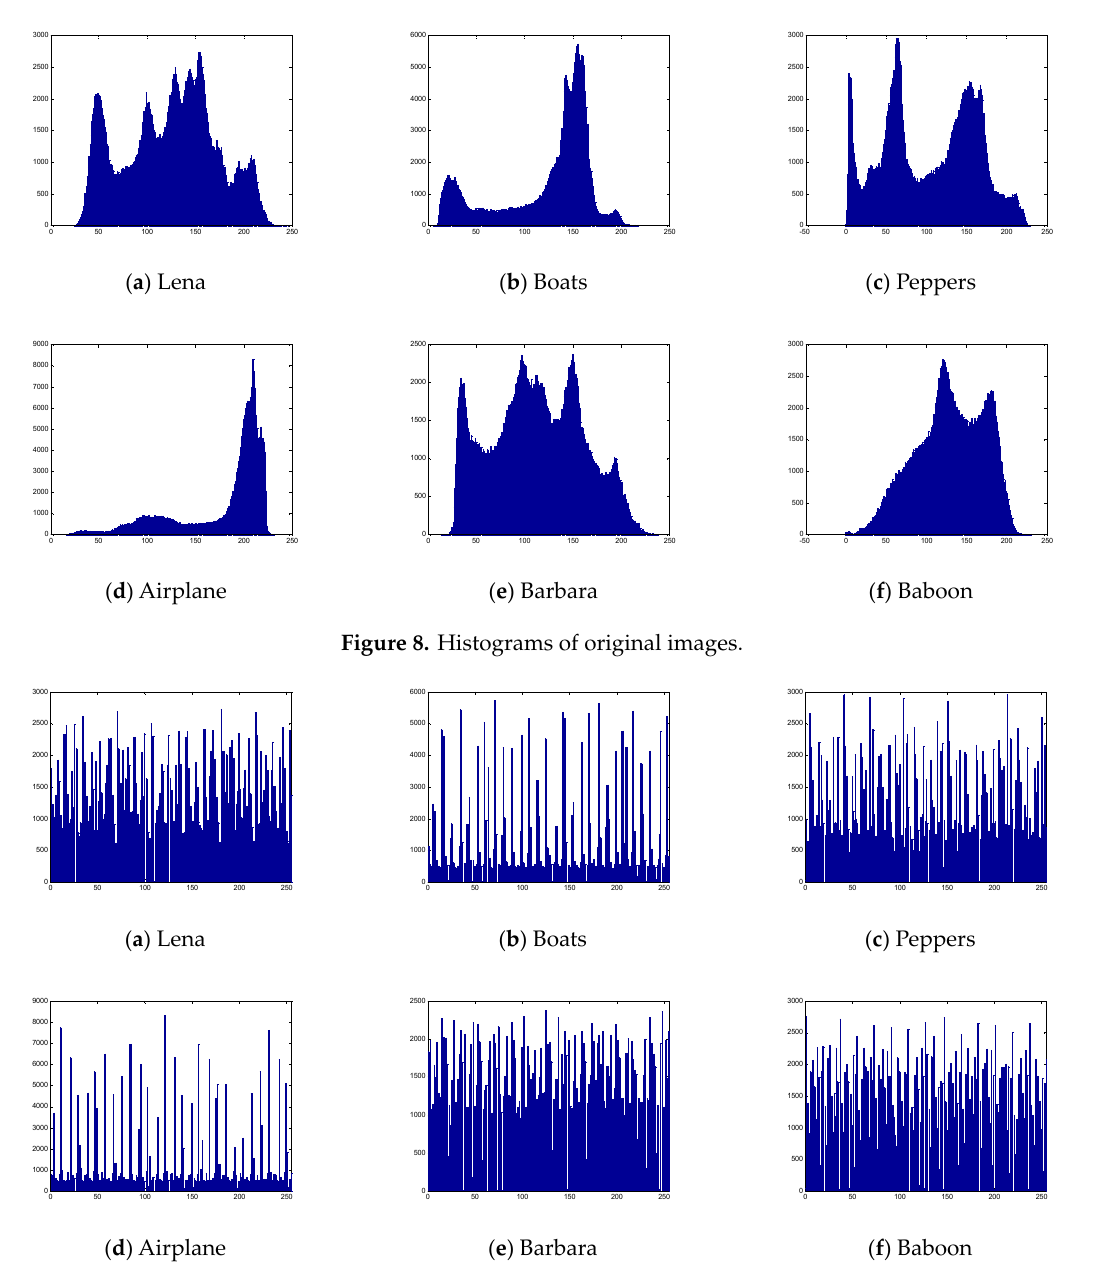
Figure 9. Histograms of encrypted images.